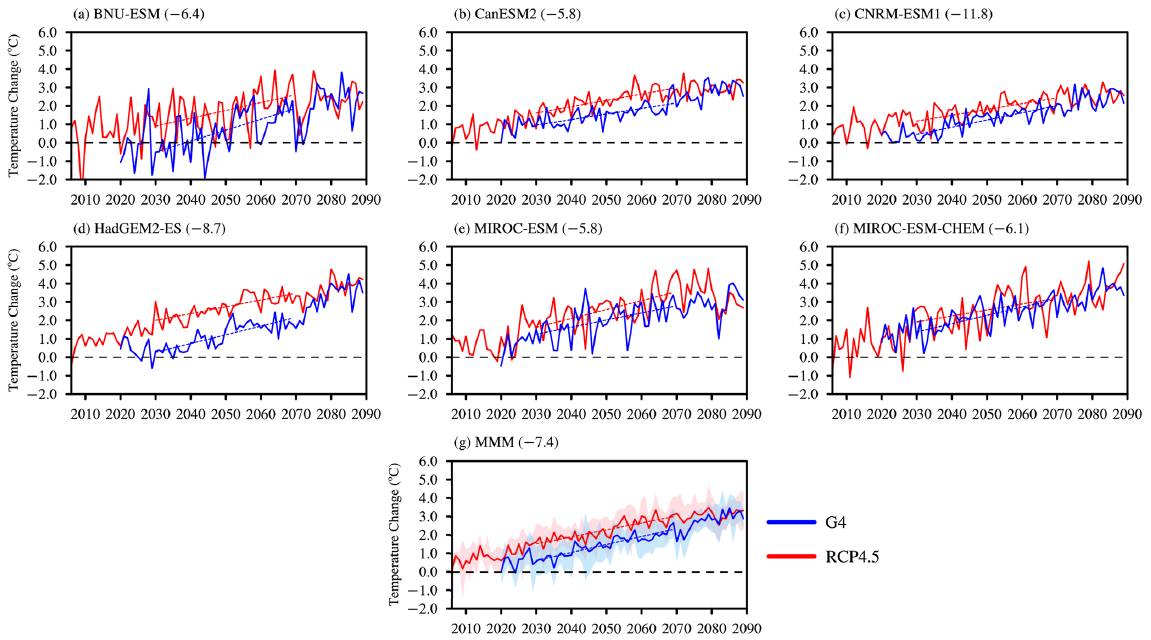
Figure 5. Same as Fig. 4 but in winter.